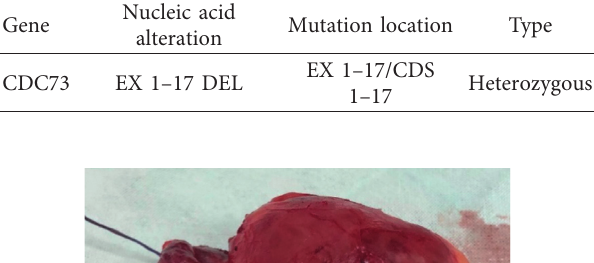
Table 2: Characteristics of positive CDC73 mutation.